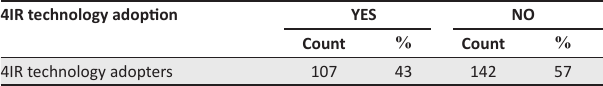
TABLE 2b: Small and medium enterprise supply chain and Fourth Industrial Revolution technology adoption.